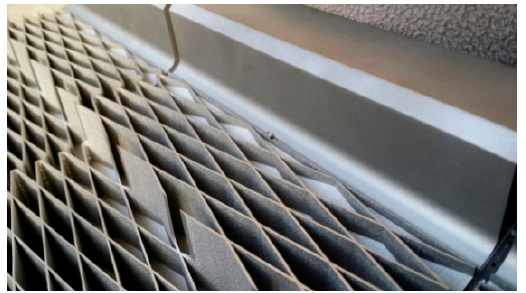
Figure 16. Test Article (TA) stator land with R3 rhomboidal cells.